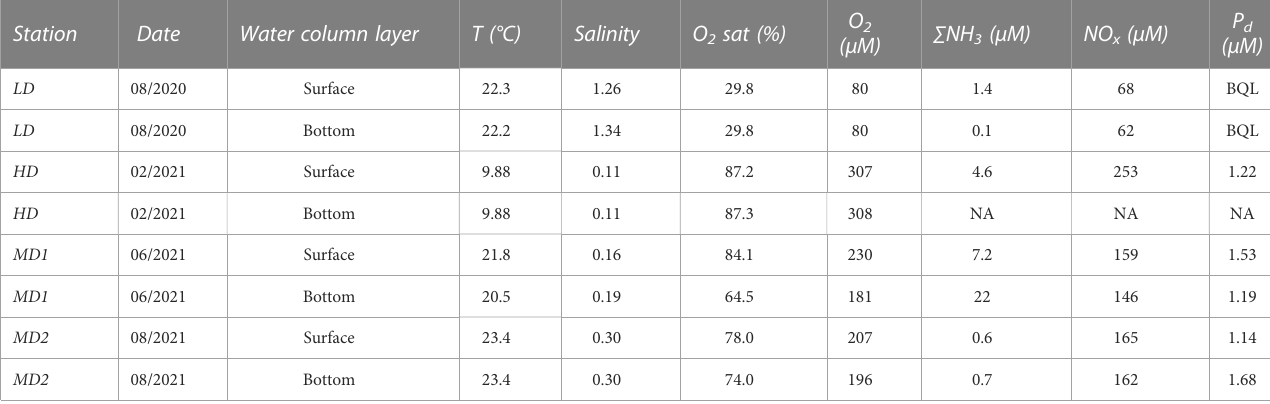
TABLE 1 Physical and chemical properties of surface and bottom waters at Le Pellerin.